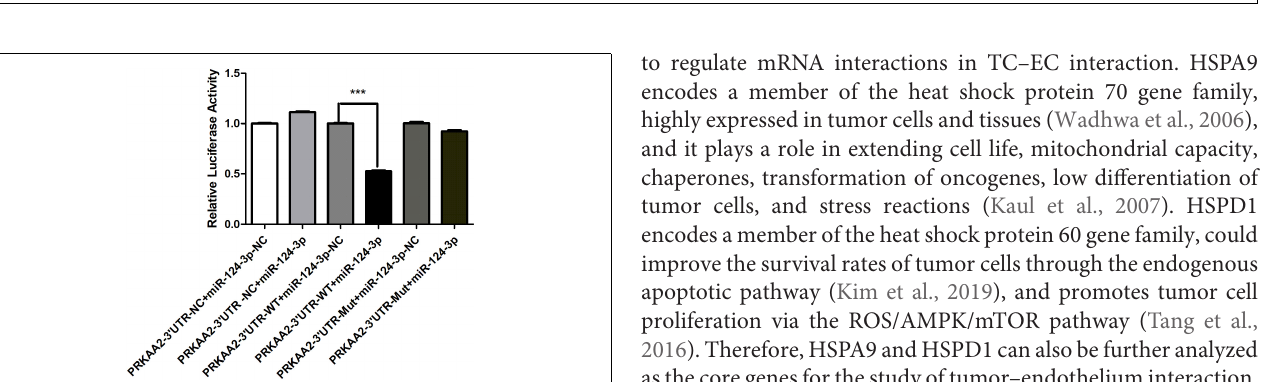
FIGURE 7 | PRKAA2 expression increased with miR-124-3p knockdown in endothelial cells adhered by PC-3M. (A) The expression level of miR-124-3p in endothelial cells under fluorescence microscope by green fluorescence protein. BF, bright field; GFP, green-fluorescent protein; NC-miR-124-3p: negative control of lentiviral vector; miR-124-3p-down: miR-124-3p knockdown with lentiviral vector. (B) qPCR analysis of relative expression levels of PRKAA2 in HUVECs transfected with LV-miR-124-3p-down. The results show that the expression level of PRKAA2 mRNA in endothelial cells adhered by PC-3M increased greatly with the knockdown of miR-124-3p.